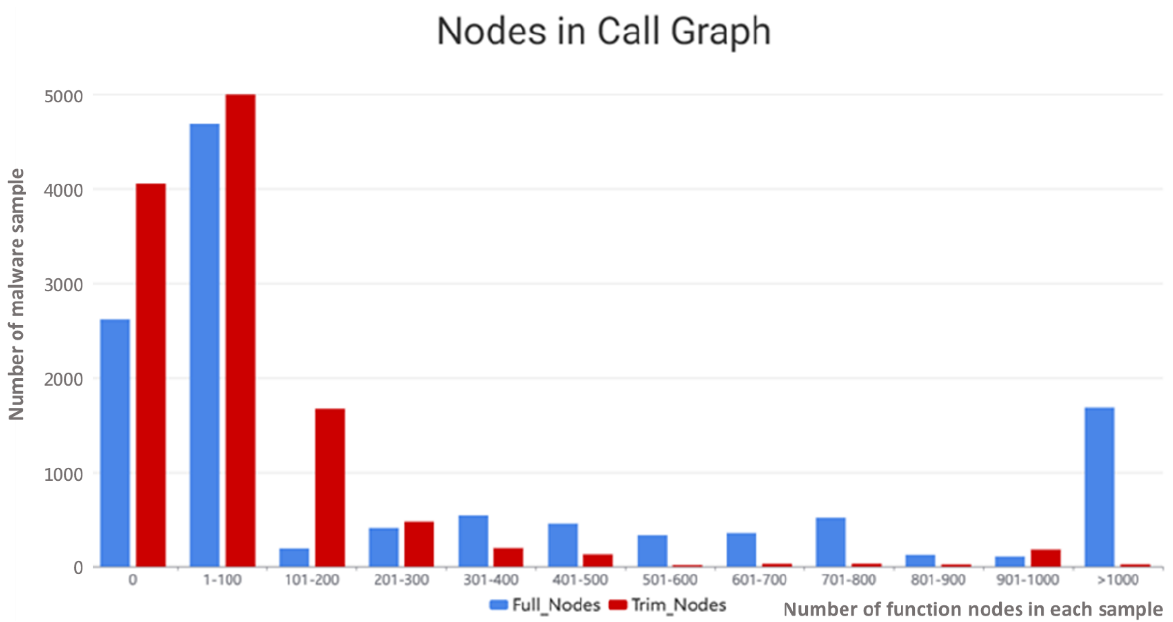
Figure 4. Nodes in call graph.